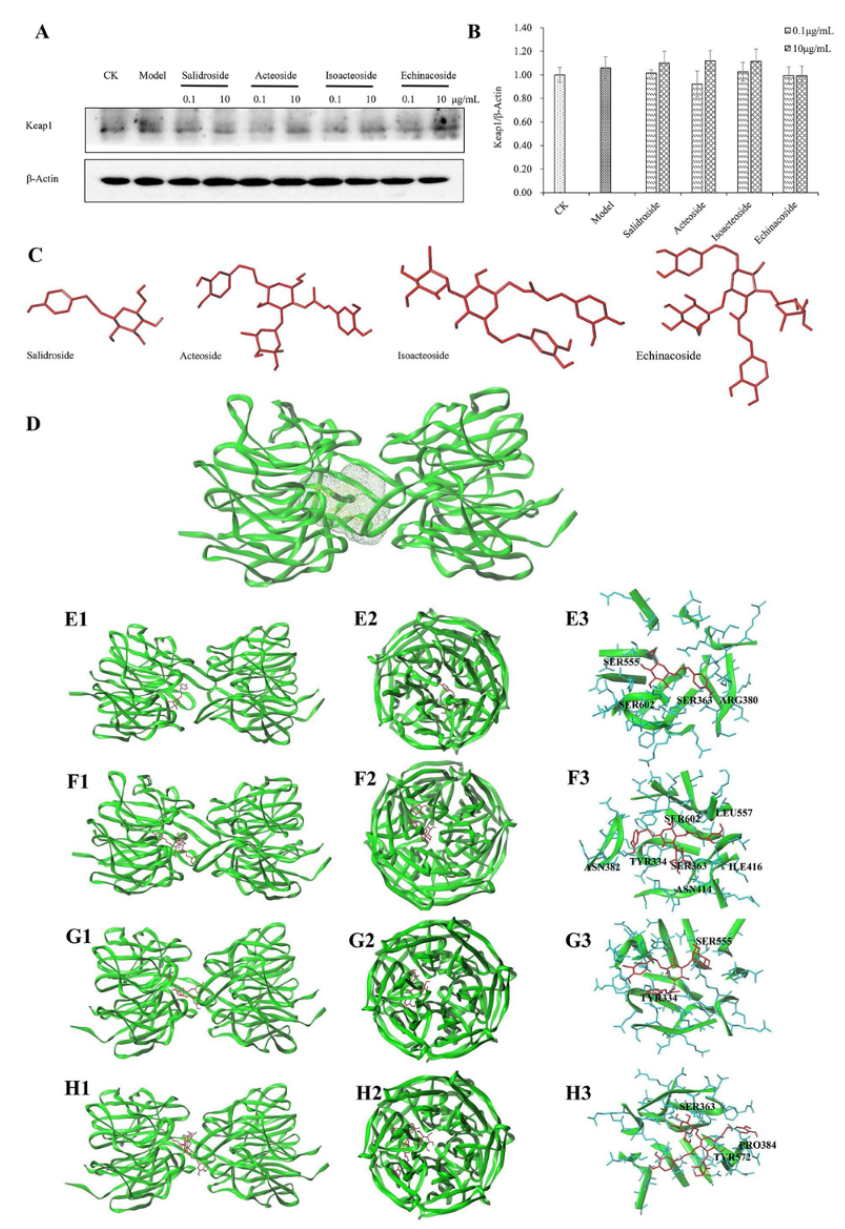
Figure 7. Effect of PhGs on Keap1 expression and molecular docking results. ( A ) PC12 cells were incubated with PhGs (0.1, and 10 µ g/mL) for 24 h, and then incubated with 200 µ M H 2 O 2 for another 2 h after the PhGs were removed. Keap1 protein expression was detected by Western blotting using specific antibody, and β -actin was used as loading control. ( B ) The quantitative densitometric analysis of Keap1 protein. ( C ) 3D structure of salidroside, acteoside, isoacteoside, and echinacoside ( D ) The binding pocket of Keap1. ( E1 – E3 ) Representative amino acid residues surrounding salidroside (red) in the binding pocket of Keap1 ( E1 front view, E2 side view, E3 binding sites). ( F1 – F3 ) Representative amino acid residues surrounding acteoside (red) in the binding pocket of Keap1 ( F1 front view, F2 side view, F3 binding sites). ( G1 – G3 ) Representative amino acid residues surrounding isoacteoside (red) in the binding pocket of Keap1 ( G1 front view, G2 side view, G3 binding sites). ( H1 – H3 ) Representative amino acid residues surrounding echinacoside (red) in the binding pocket of Keap1 ( H1 front view, H2 side view, H3 binding sites). The dotted line (yellow) indicate potential interactions between amino acid residues and